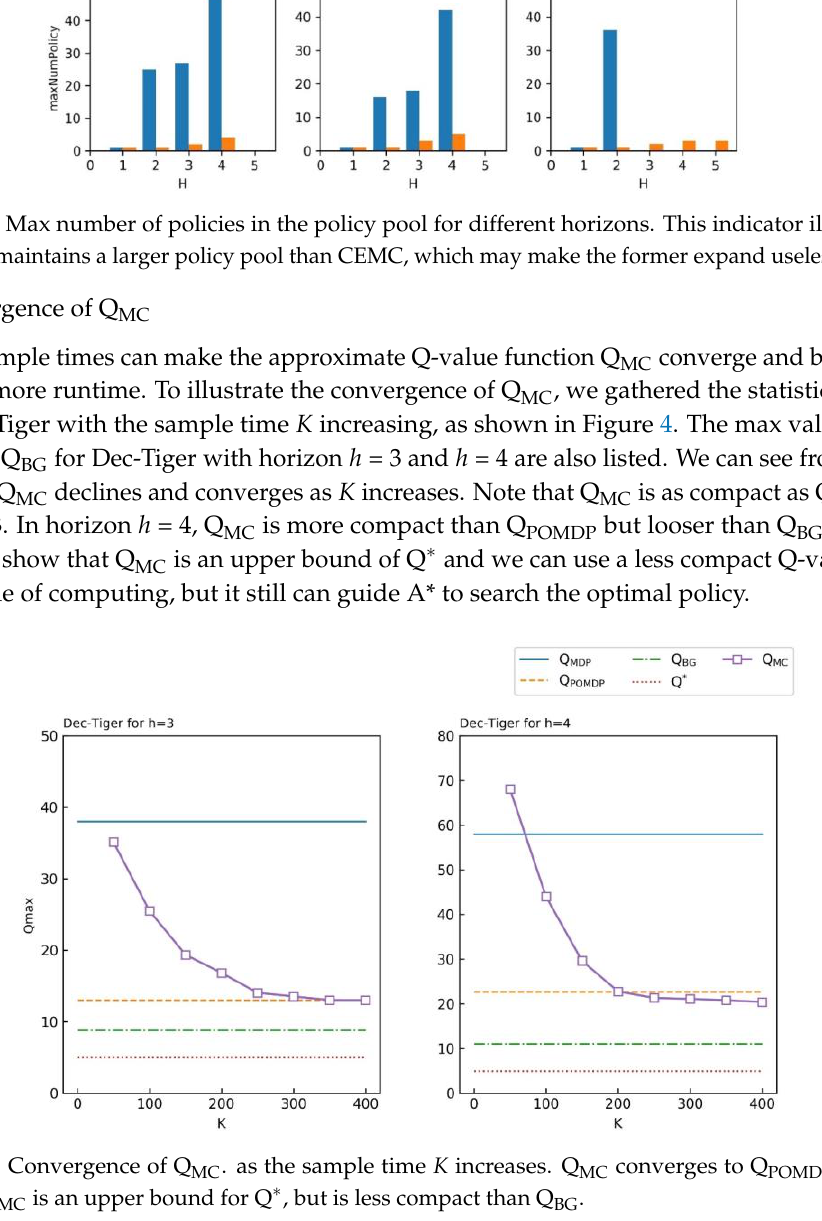
Q . means Q MC is an upper bound for Q ∗ , but is less compact than Q BG BG